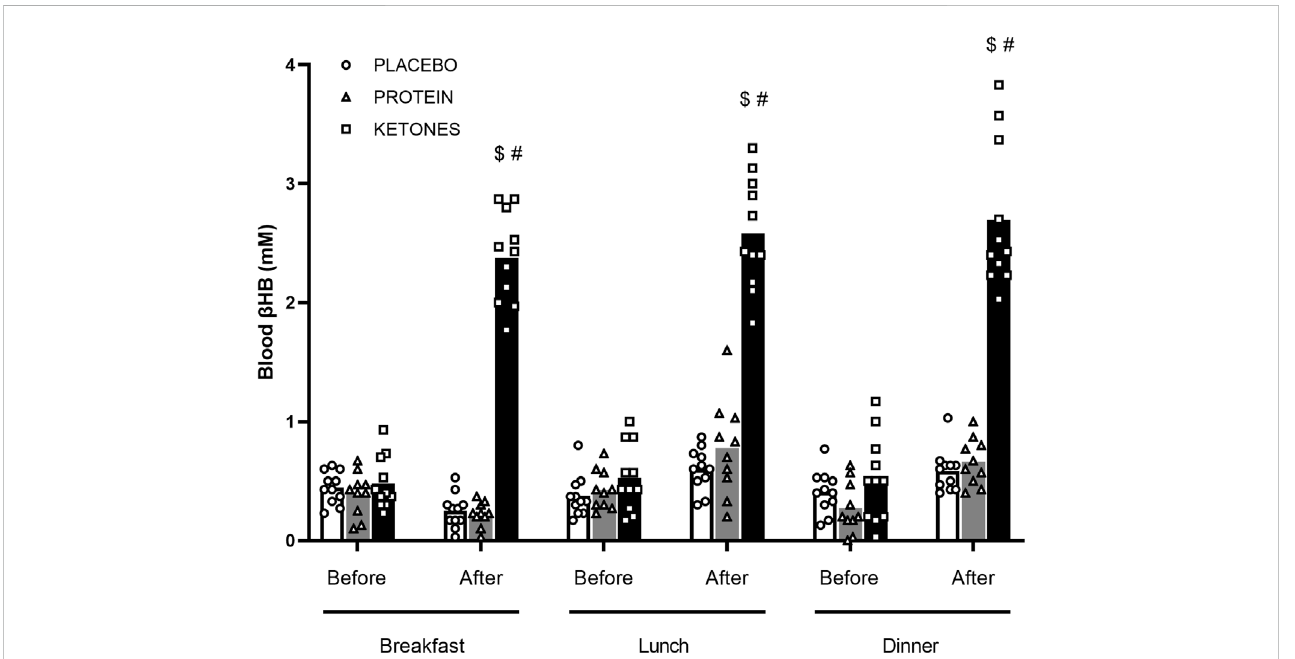
FIGURE 2 Diurnal blood β -hydroxybutyrate. Subjects were involved in a 4-week hypocaloric diet (30% energy restriction, .8 – 1.0 g protein · kg BW − 1 · day − 1 ) and receivedeitherplacebo(PLA: n =11),anincreasedamountofdietaryprotein(PROT:n=10)oraketoneester(KE: n =11).Dataarerepresentedasmeans(white bars: PLA; grey bars: PROT; black bars: KE) and individual values (circles: PLA; triangles: PROT; squares: KE). Supplements were ingested daily immediately before breakfast (8 am), lunch (12 pm) and dinner (6 pm). β HB (mM) was measured immediately before and 1h after supplement intake on day 1, 14 and 27 during the supplementation period. Because diurnal β HB levels were similar between day 1, 14 and 27, only mean values of the3 days are reported. In case of signi fi cant interaction, post hoc differences are shown as $: signi fi cantly different from the corresponding value before breakfast (p < .05), #: signi fi cantly different from PLA and PROT (p < .05).